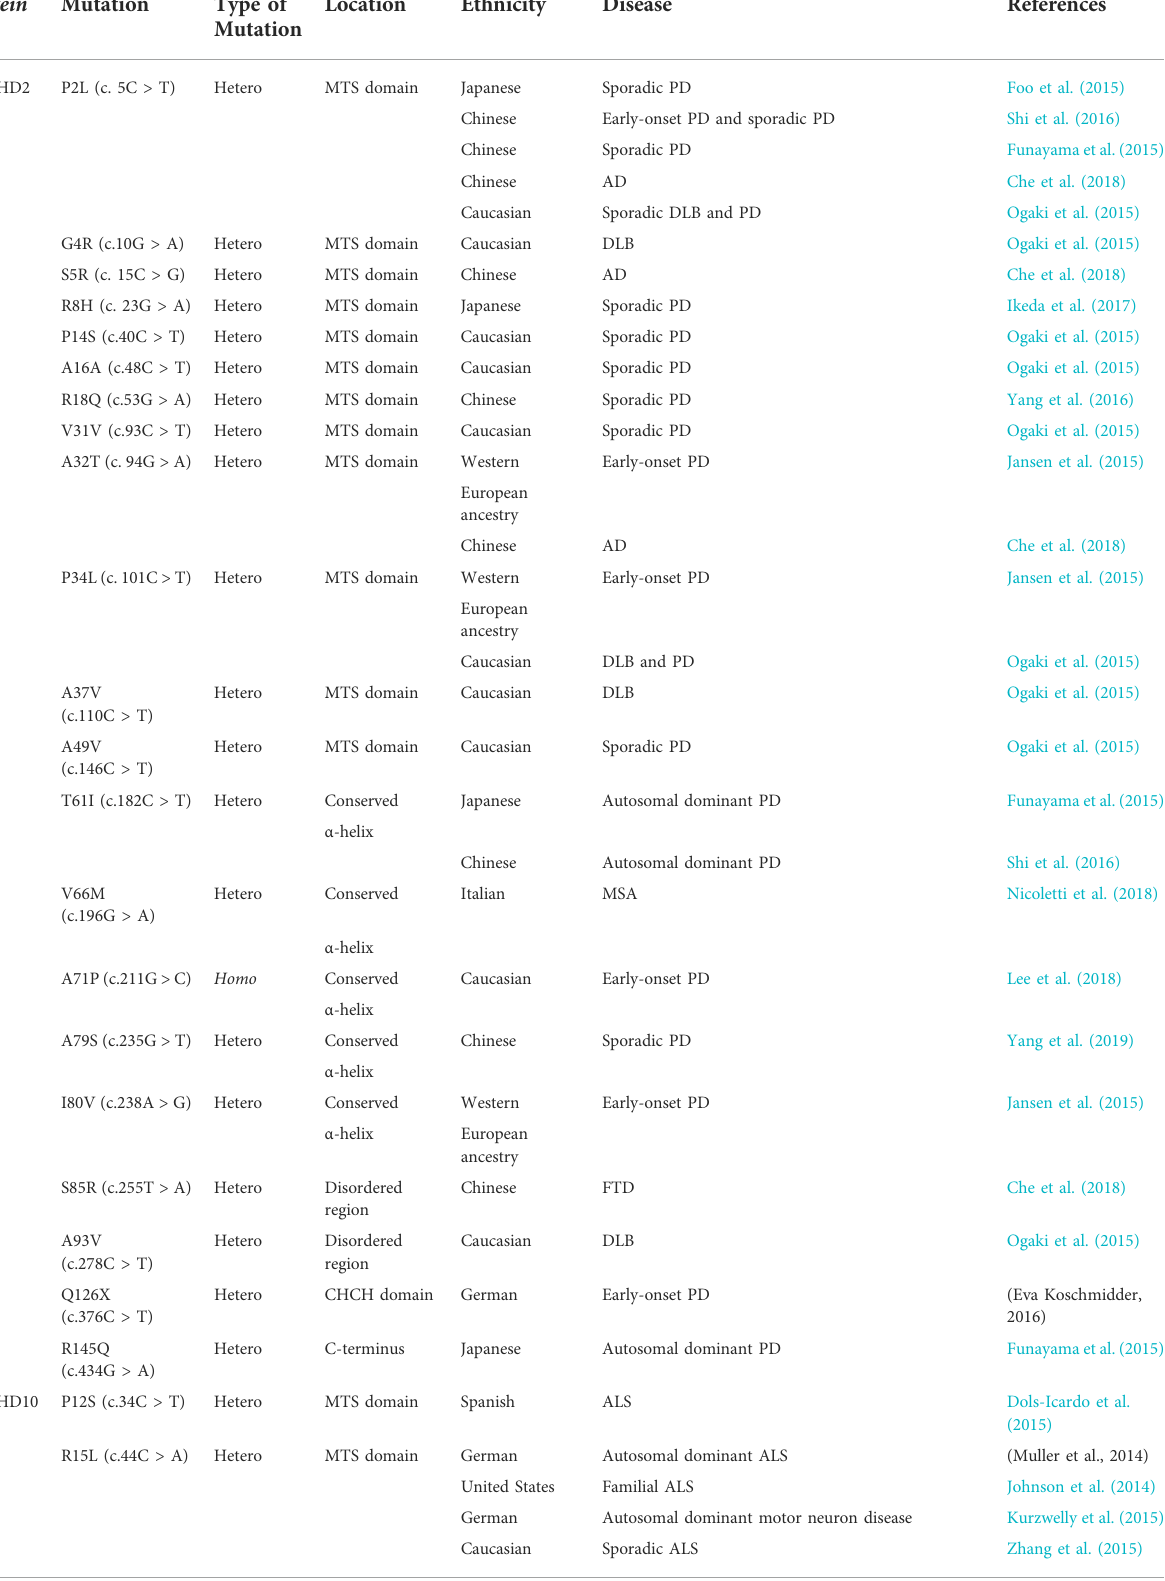
TABLE 1 Disease-associated variants of CHCHD2 and CHCHD10 .